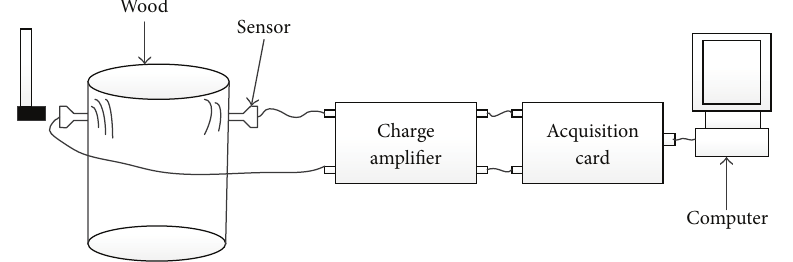
Figure 1: The structure of hardware